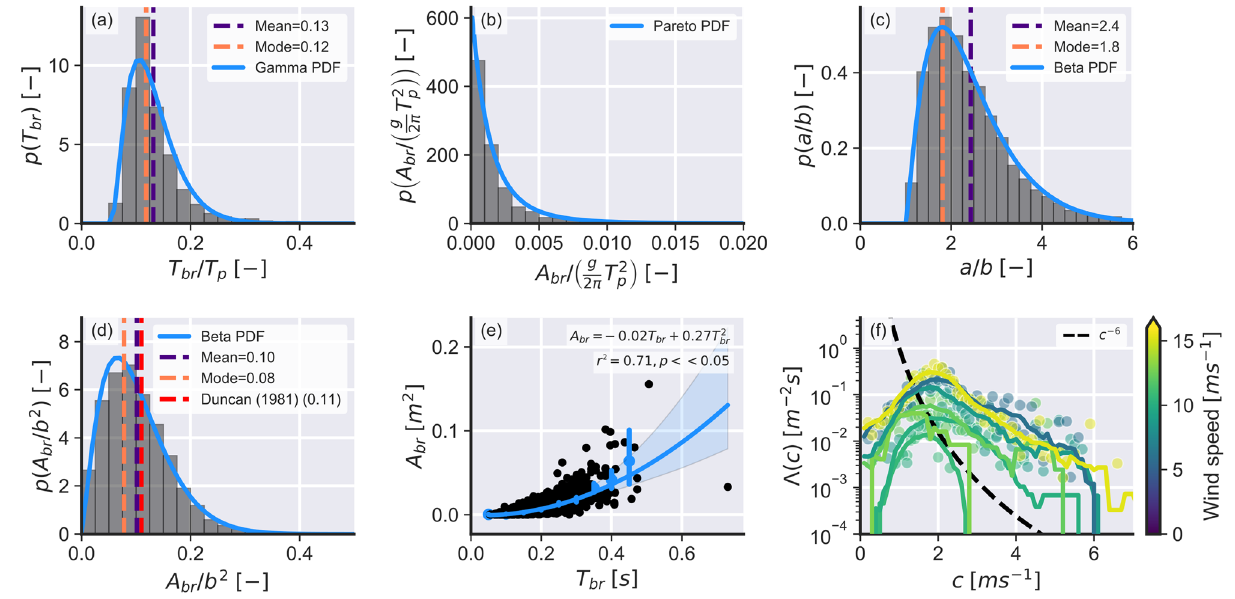
Figure 5. Examples of statistical properties of breaking waves that can be directly obtained from the proposed method. ( a ) Probability distribution of the wave breaking duration ( T br ) normalized by wave peak period ( T p ). The blue line shows the Gamma fit to the data, the purple dashed line shows the mean value (0.13) and the orange dashed line shows the mode value (0.12). ( b ) Probability distribution of the wave breaking area ( A br ) 2 normalized by wavelength ( g 2 π T p ). The blue line shows the Pareto fit to the data. ( c ) Probability distribution of the ratio between major and minor axis ( a / b ). The blue line shows the Beta fit to the data, the purple dashed line shows the mean value (2.4) and the orange dashed line shows the mode value (1.8). ( d ) Probability distribution 2 of the wave breaking area scaling parameter ( A br / b ). The blue line shows the Beta fit to the data, the purple dashed line shows the mean value (0.1), the orange dashed line shows the mode value (0.08), and the red line shows Duncan’s constant value (0.11). ( e ) Evolution of the wave breaking area over time. The black markers show the observed values, the error bars show values binned at 0.15 s intervals, the blue line shows the quadratic 2 regression to the data, the blue swath shows the 95% confidence interval for the regression, and r is the correlation coefficient. ( f ) Phillips 12 �( c ) dc distributions assuming that the wave breaking speed is the same as 6 the phase speed of the carrier wave (that is, c = c br ) grouped by wind speed. The black dashed line shows the c − 1 theoretical decay, the colored markers show the average crest length binned at 0.1 ms − wave speed intervals, and the colored lines show a running average with a window size of 10 bins.